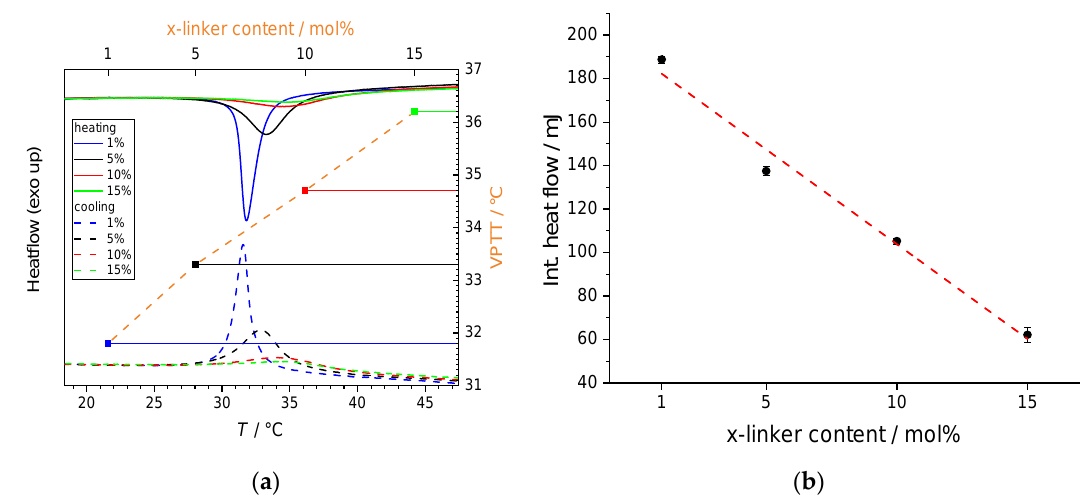
Figure 1. ( a ) DSC thermograms (heating: solid lines; cooling: dashed lines) of neat µ-PNiPAM microgels (1 wt.% in H 2 O) with different crosslinker content (left and bottom axis) and VPTT (squares, orange axis labels) as extracted from heating curves. Lines between squares are guides to the eye. A constant offset is subtracted from the heat flow to adjust for baseline differences. ( b ) Integrated heat flow for the phase transitions of neat microgels during heating cycle for different crosslinker contents.